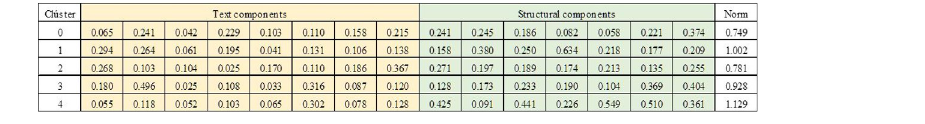
Fig 8. Centroids of each